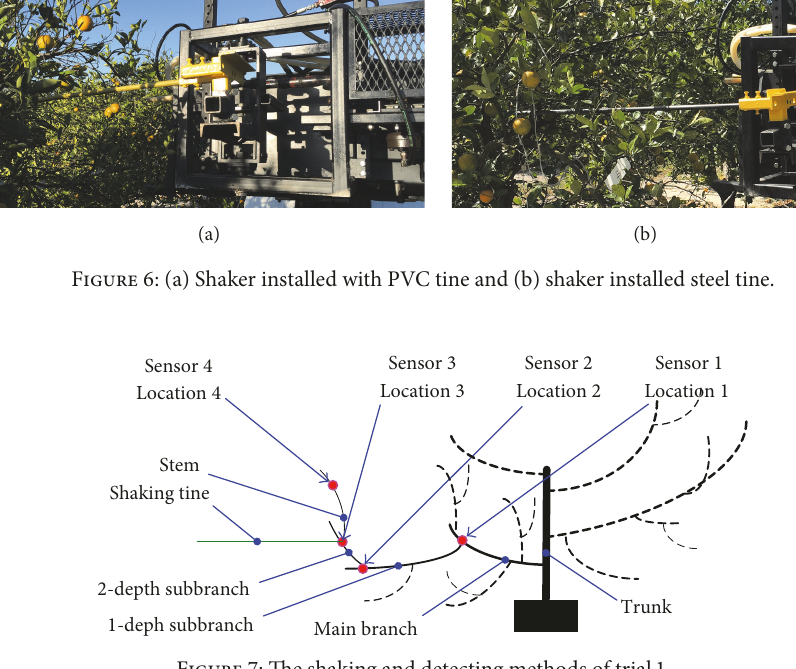
subbranch2-depth Main branch1-deph Figure 7: The shaking and detecting methods of trial 1.